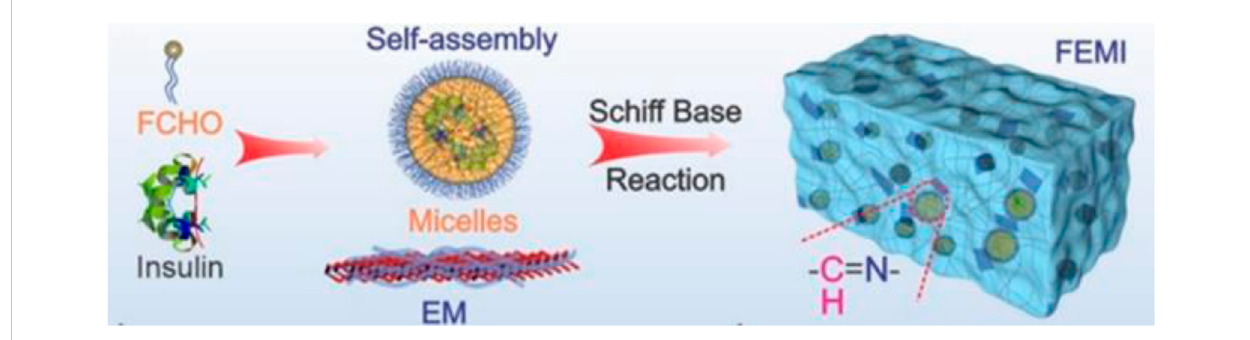
FIGURE 11 Components of the gel (Wang et al., 2020b). Reprinted with permission from (Wang et al., 2020b). Copyright 2020 American Chemical Society.